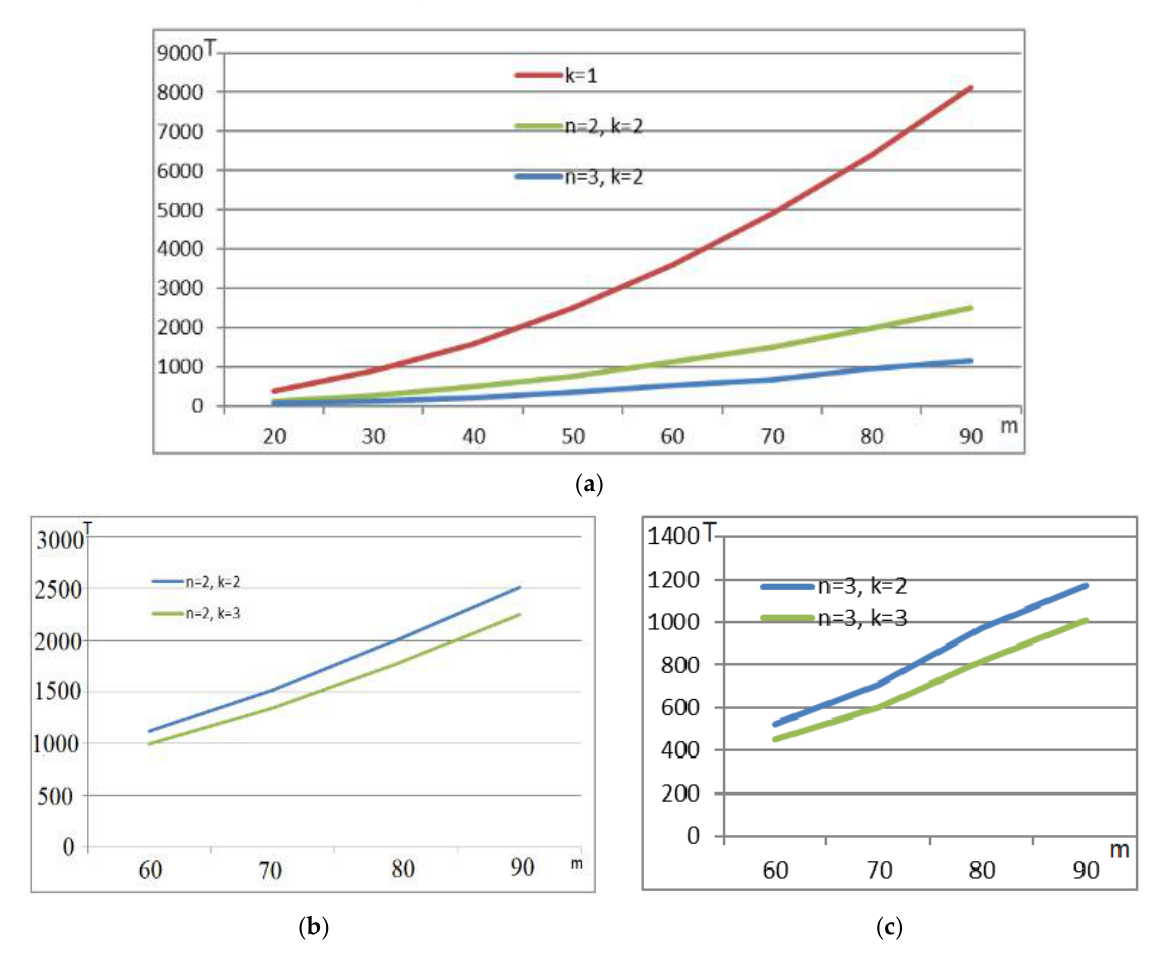
Figure 6. Complexity of synthesis of multilevel models relative to single-level: ( a )—the complexity of the synthesis of two-level models relative to one-level; ( b )—the complexity of the synthesis of three-level models relative to two-level at n = 2; ( c )—the complexity of the synthesis of three-level models relative to two-level at n = 3.